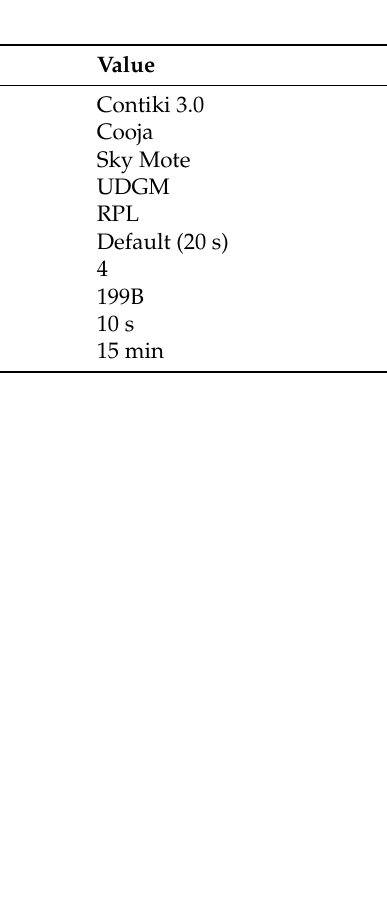
Figure 11. Network